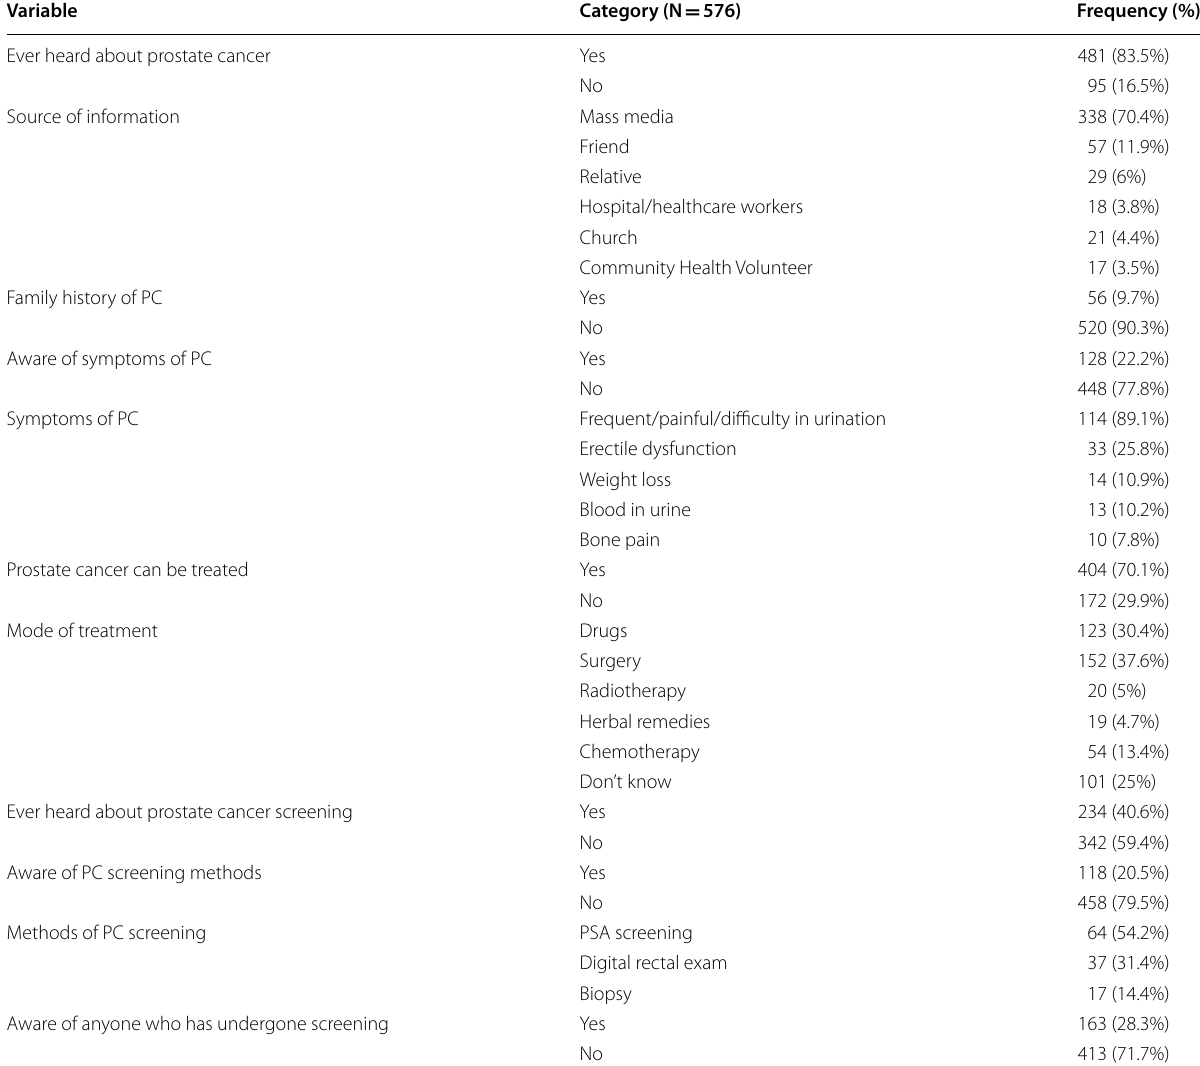
Table 2 Knowledge and awareness of prostate cancer